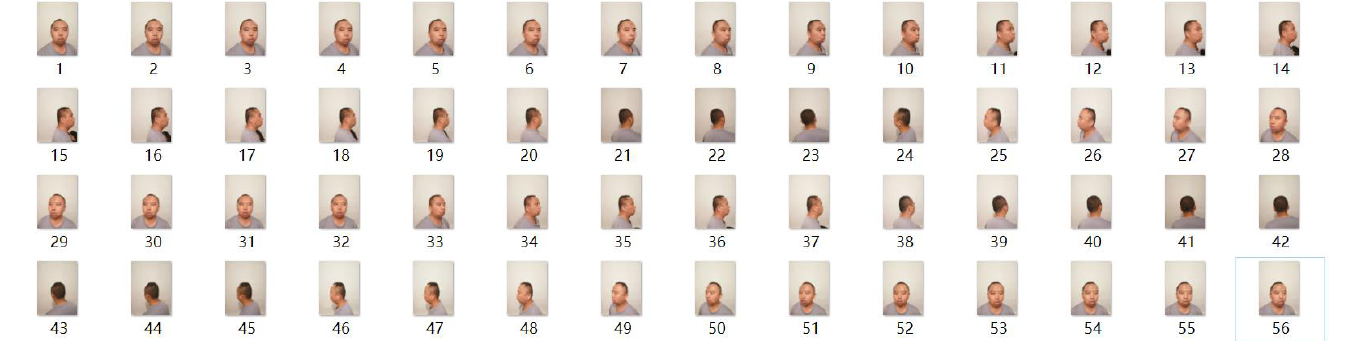
Figure 3. Scanning tool.